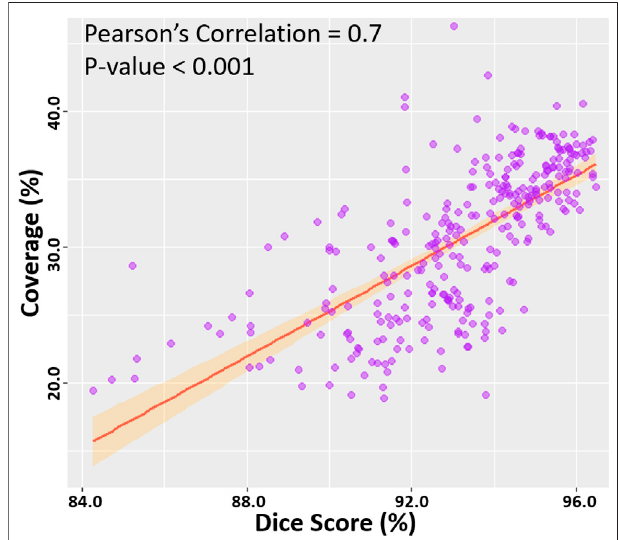
FIGURE5| Correlationofthepointcloudcoveragewiththedicescorein the testing datasets. The line of best fi t is shown, along with the Pearson ’ s correlation value and p -value. The band shows the standard deviation of the points along the